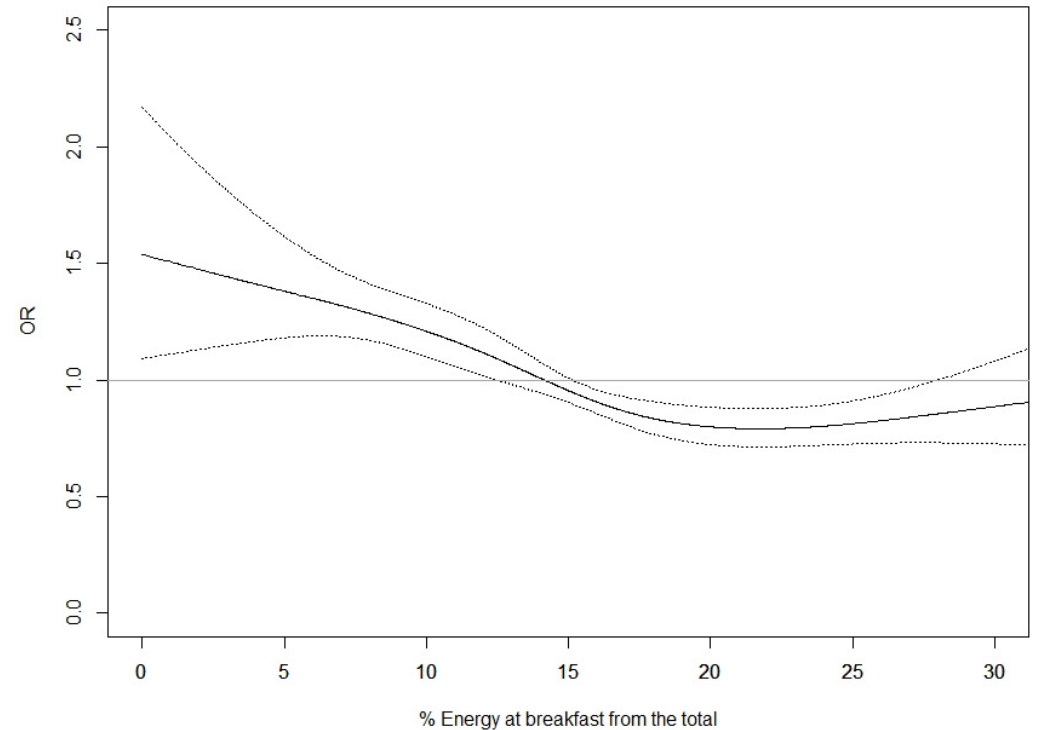
Figure 1. Percentage of energy at breakfast from the total daily energy intake and prevalence of Metabolic Syndrome. Logistic regression model was adjusted for center, sex, age, educational level, recreational physical activity, number of eating occasions ( ≤ 3, 4–5, >5), and breakfast time ( ≤ 9:00, >9:00).